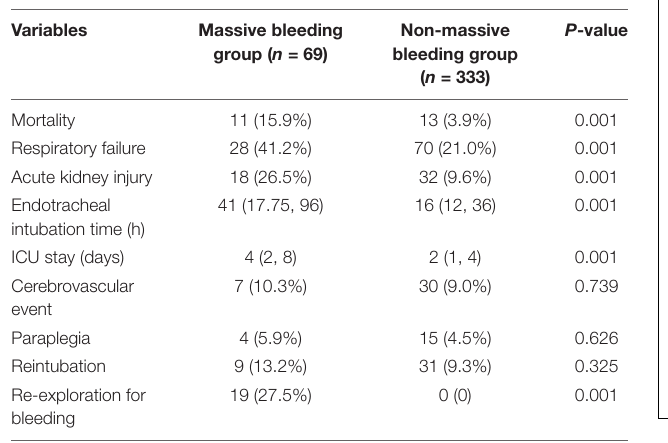
TABLE 4 | Short-term outcomes of study population.